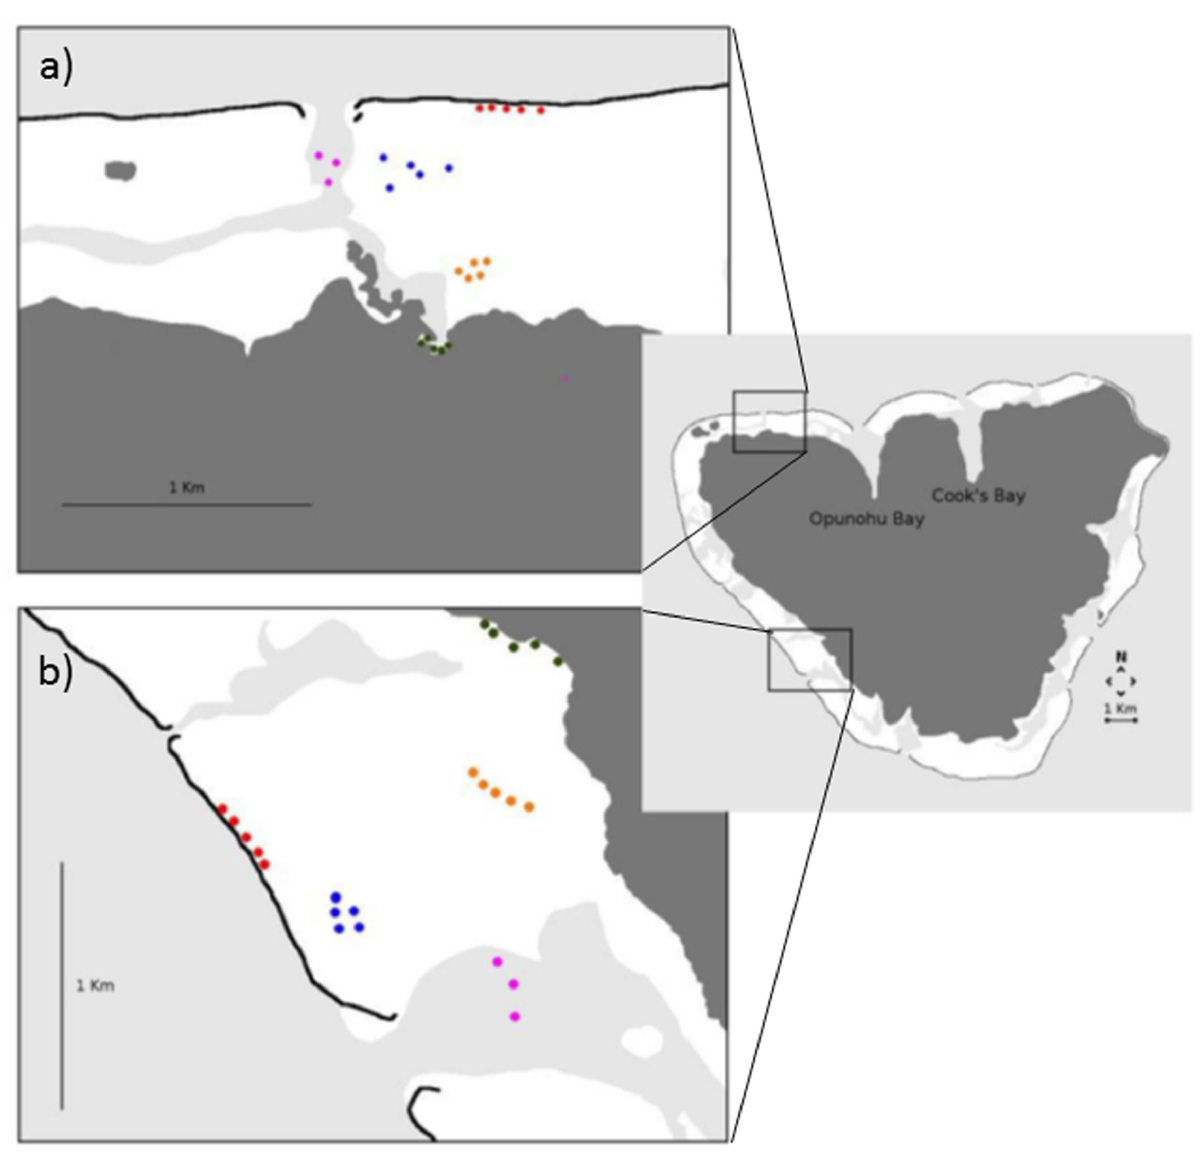
Fig 1. Maps of the North (a) and West (b) coasts of Moorea Island. Locations of the sound recordings for each of the five habitats (red dots = reef crest; blue dots = barrier reef; purple dots = pass; orange dots = fringing reef and green dots = mangrove forest). Maps drawn by the authors from an aerial photograph of Moorea taken by the CRIOBE in 2008 from a private plane. For representative purposes